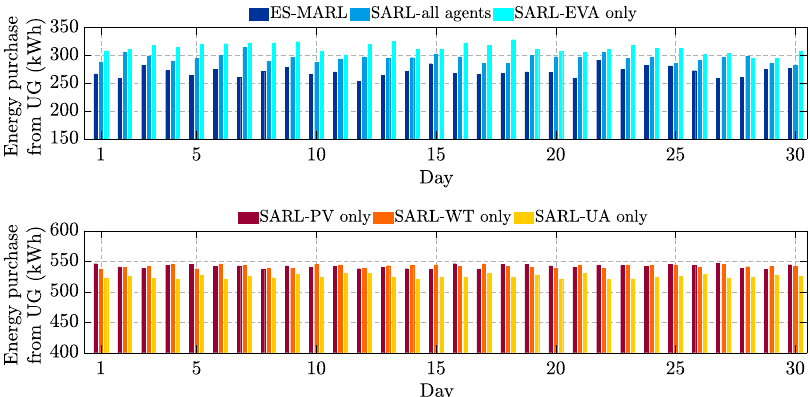
Figure 10. Daily energy purchase from UG in different RL configurations for microgrid configuration 1.